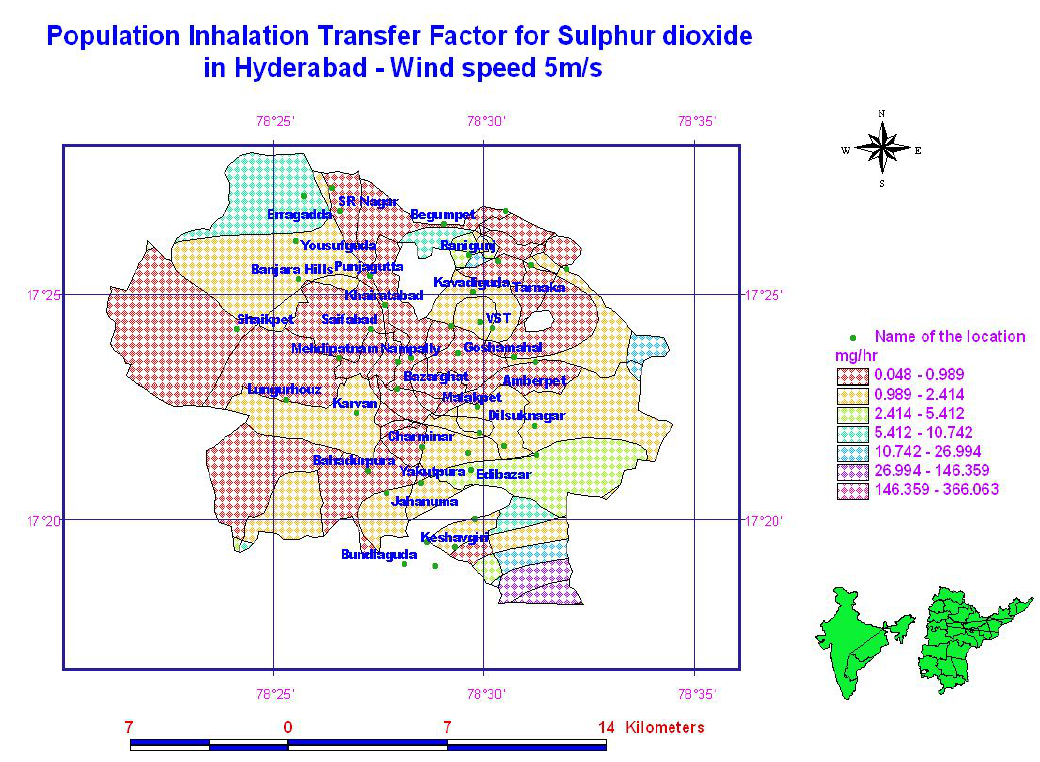
Figure 15: Population inhalation transfer factor for sulphur dioxide in Hyderabad – wind s peed